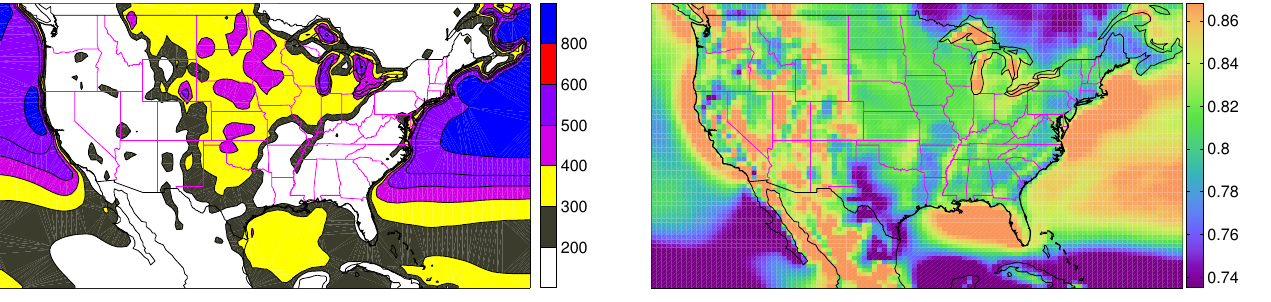
Fig. 4. Geographical variation of coefficient of variation of WPD across the US.